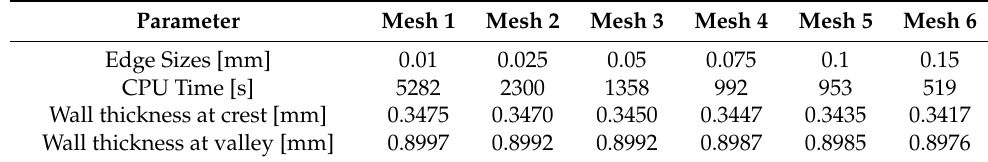
Figure 6. Finite element meshes used. Table 1. Mesh sensitivity analysis.